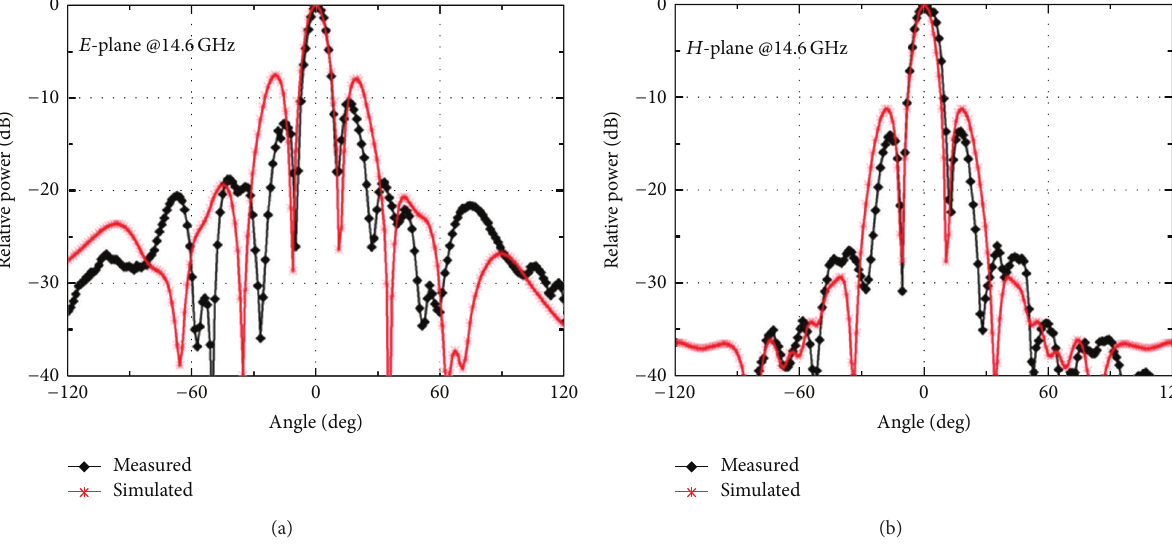
Figure 7: Radiation patterns of 2 × 2 element patch array with MTMs-cover: (a) 𝐸 -plane; (b) 𝐻